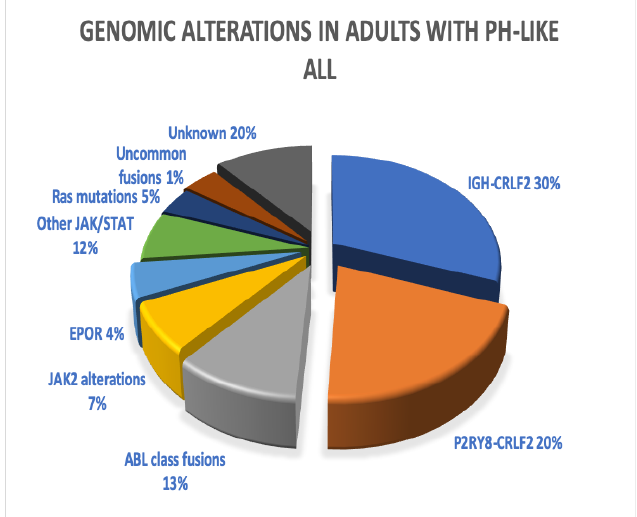
Figure 2. Genomic alterations in adults with Ph-like acute lymphoblastic leukemia (ALL). Pie chart constructed with data from Roberts et al. [67].